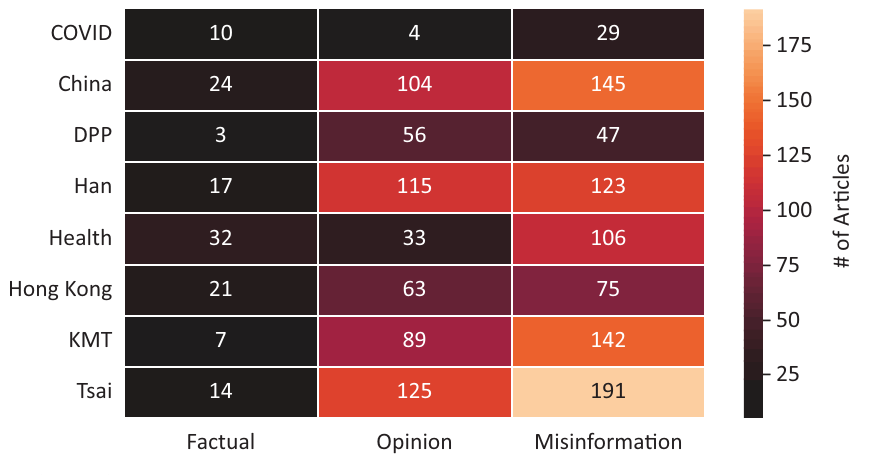
Figure 5. Heat map of misinformation classification by topic. thus completes our addressing of RQ3 and confirmation of H3.